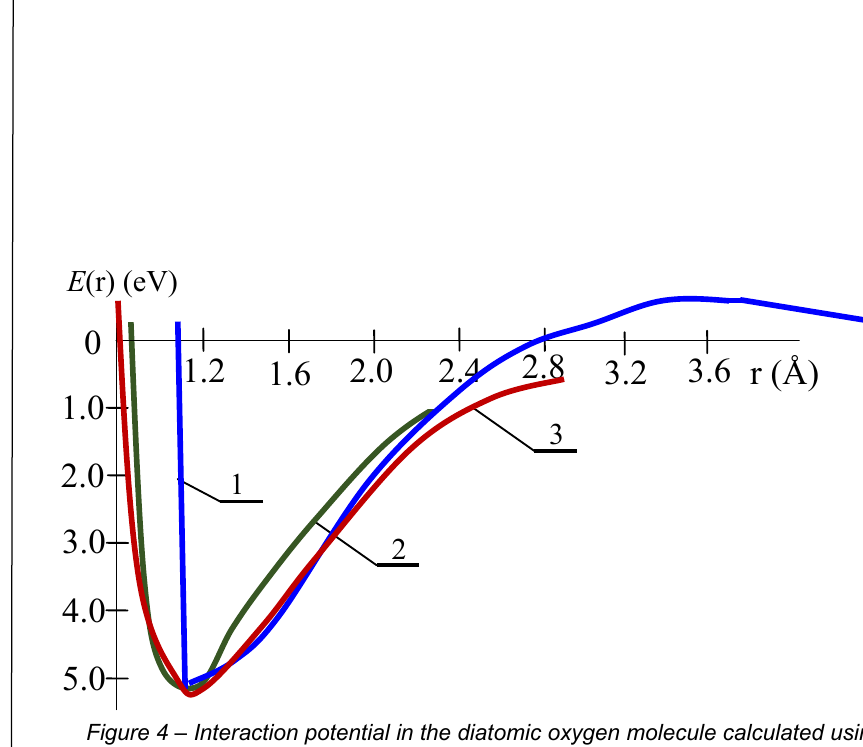
Figure 4 – Interaction potential in the diatomic oxygen molecule calculated using: 1 - formula (25); 2 - Lennard-Jones formula; 3 - Morse formula Рис . 4 – Потенциал в двухатомной молекуле кислорода полученный по формуле : 1 - (25); 2 - Леннарда - Джонса ; 3 - Морзе Слика 4 – Потенцијал интеракције у двоатомском молекулу кисеоника добијен